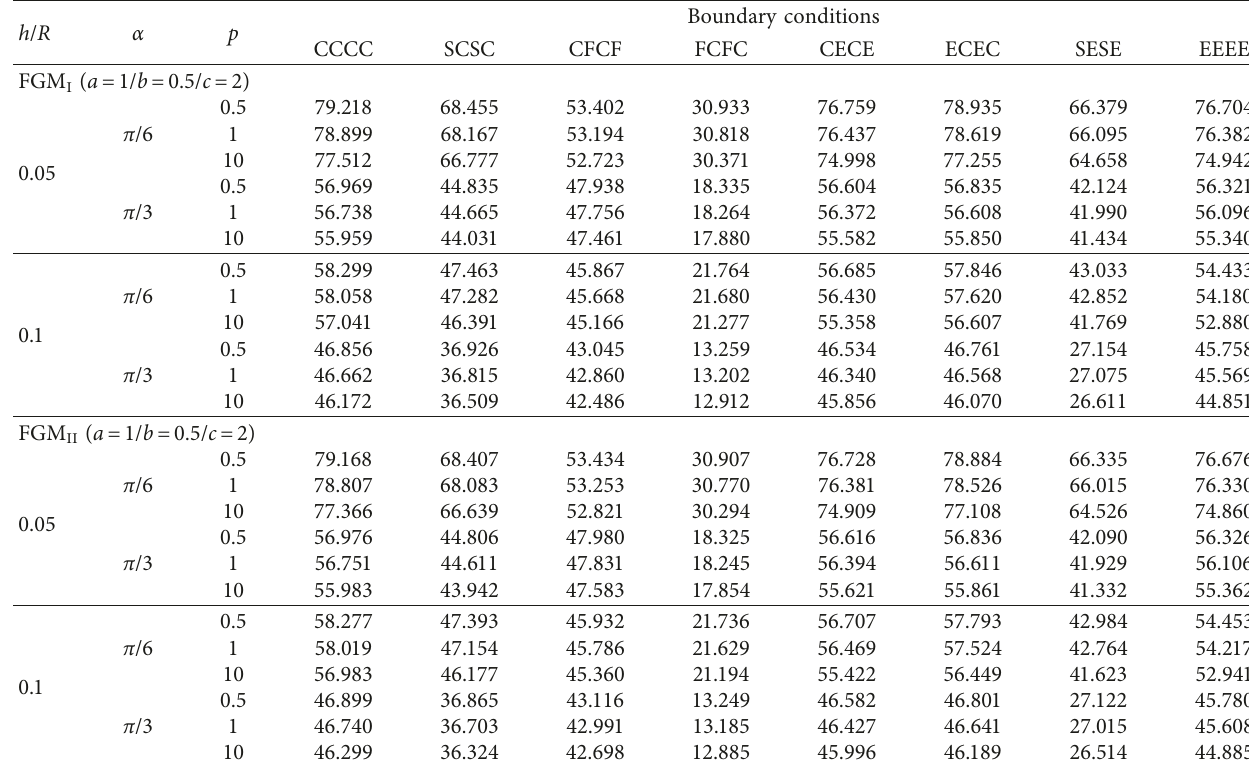
Table 9: Fundamental frequency parameters for FGOS with two circumferential bulkheads and various boundary conditions ( R � 1 m,